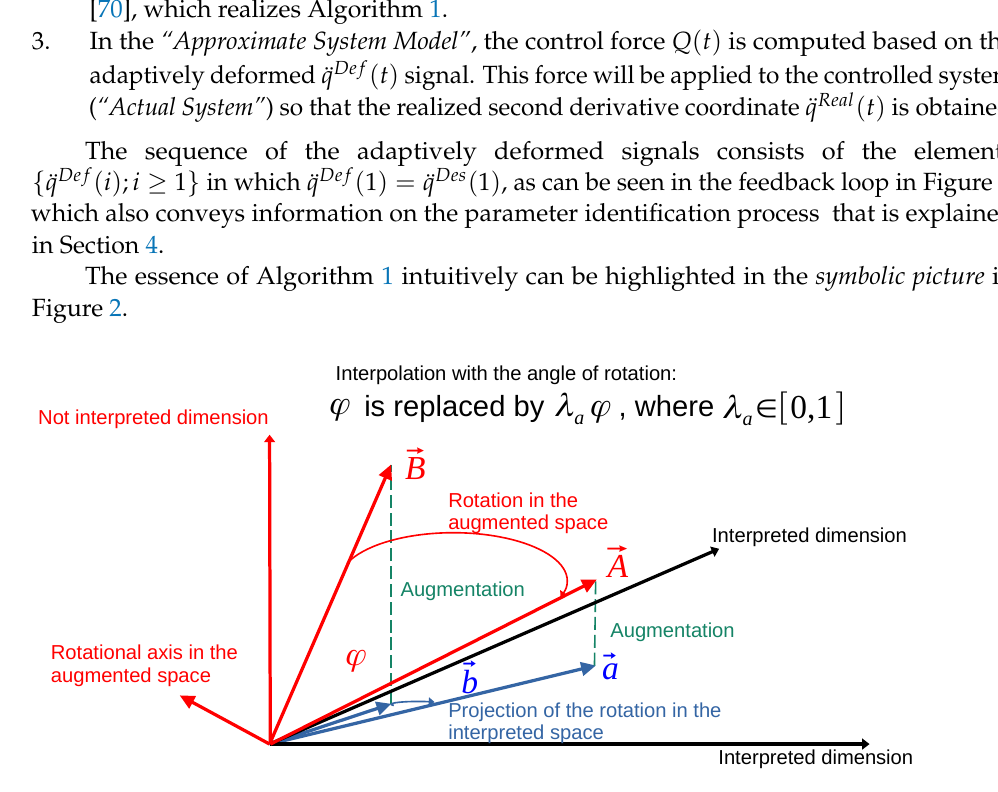
Figure 2. The symbolic description of the “abstract rotations”: the vectors of physically interpreted components a , b ∈ R n are so augmented into the vectors A , B ∈ R n + 1 by adding further orthogonal components to them that (cid:107) A (cid:107) = (cid:107) B (cid:107) in the sense of the Frobenius norm. These vectors determine a TWO-dimensional plain within which B can be rotated into A with angle ϕ . The axis of the rotation is the ( n + 1 ) − 2-dimensional orthogonal subspace of this plain. Due to this rotation the physically interpreted projection of B , which is b , is exactly transformed into the physically interpreted projection of A , i.e., into a . The projections suffer rotation and dilatation or shrinking in R n . With the parameter λ a ∈ [ 0,1 ] , by making a rotation only with the angle λ a ϕ instead of ϕ some nonlinear interpolation can be